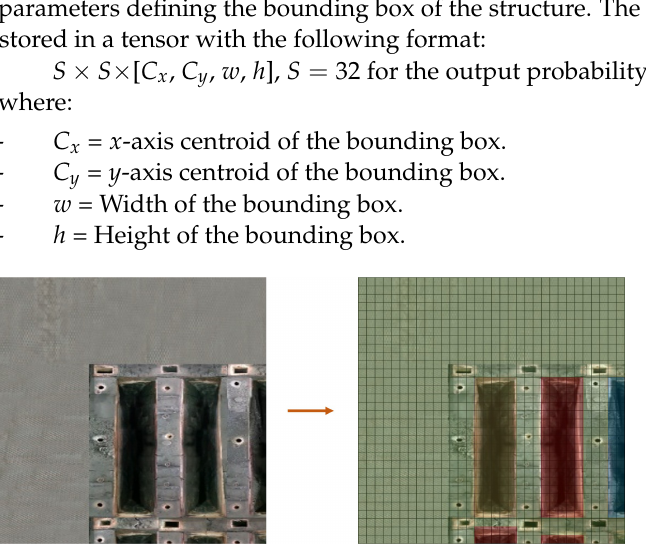
Figure 7. Prediction class probability